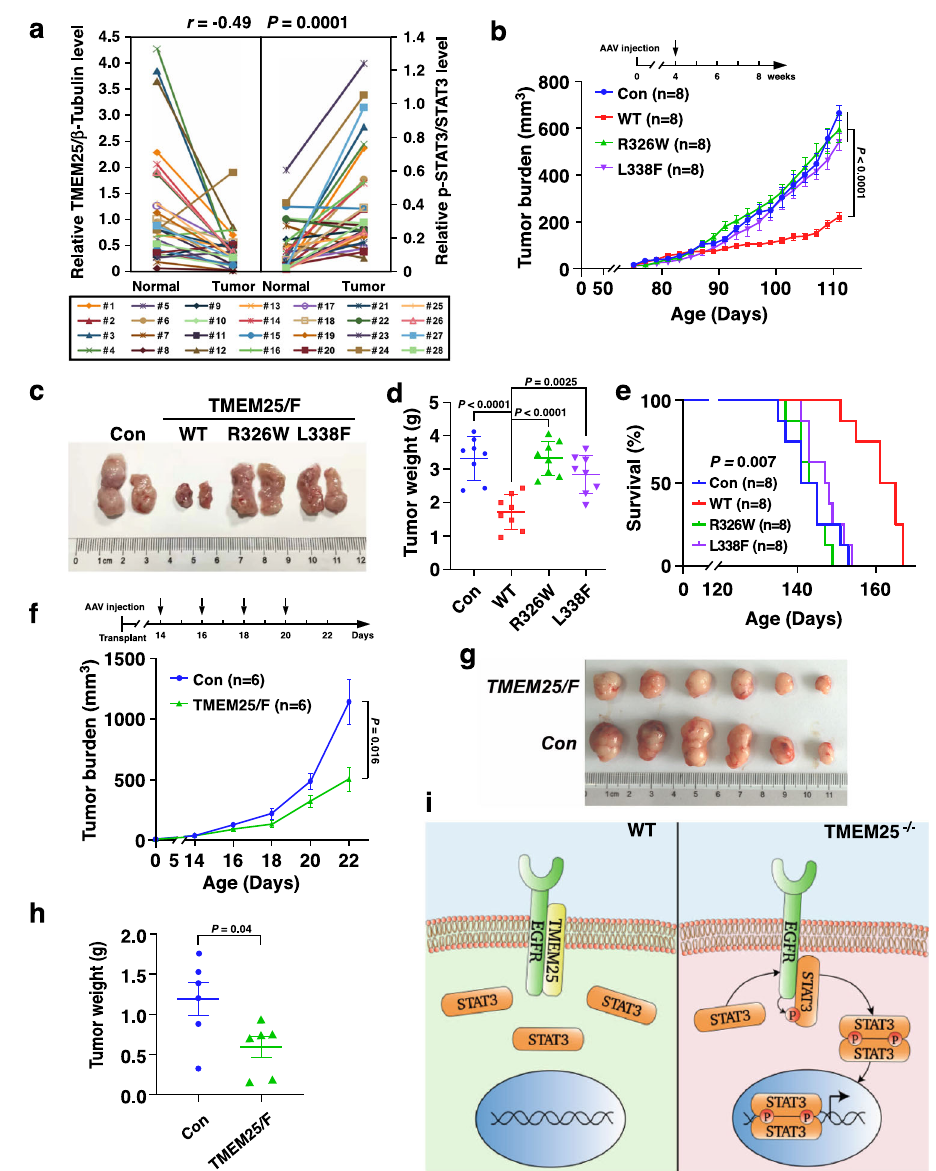
levels are frequently decreased and negatively correlated with phospho-STAT3 levels in TNBC. TMEM25 and phospho-STAT3 levels in 28 human TNBC samples mined by Spearman ’ s rank correlation analysis and two-tailed unpaired t